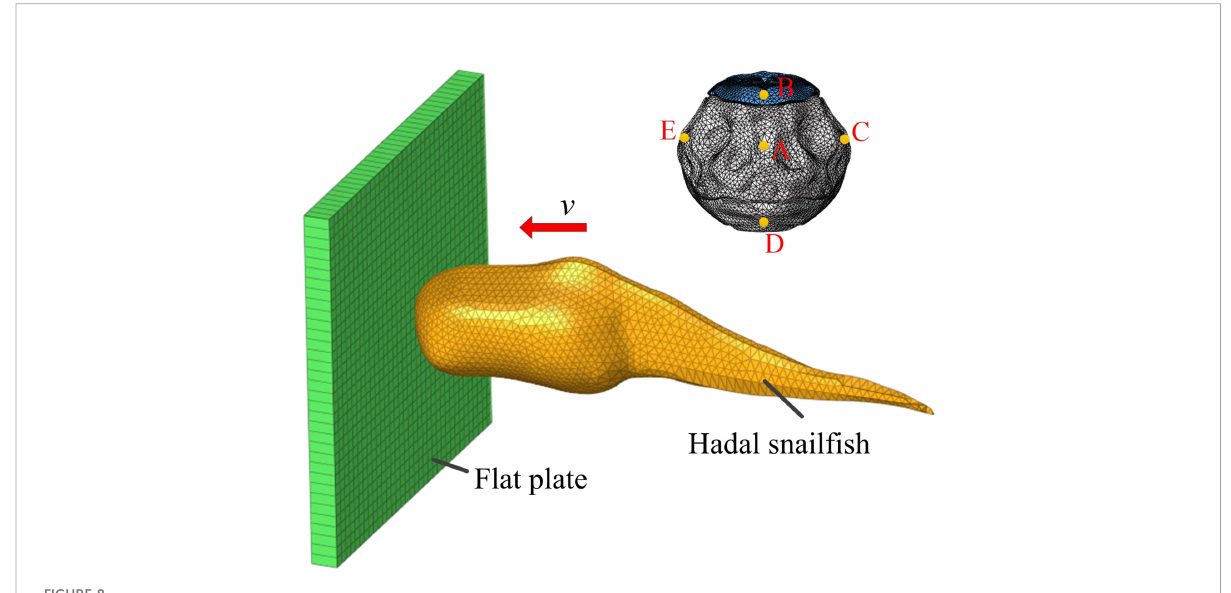
FIGURE 8 Simulation model of hadal snail fi sh